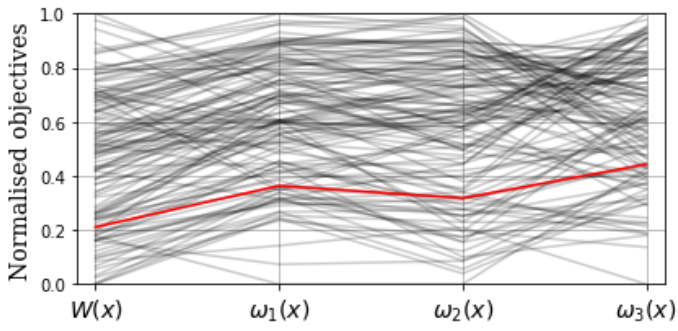
Figure 20. Parallel Coordinates plot of the PF obtained for